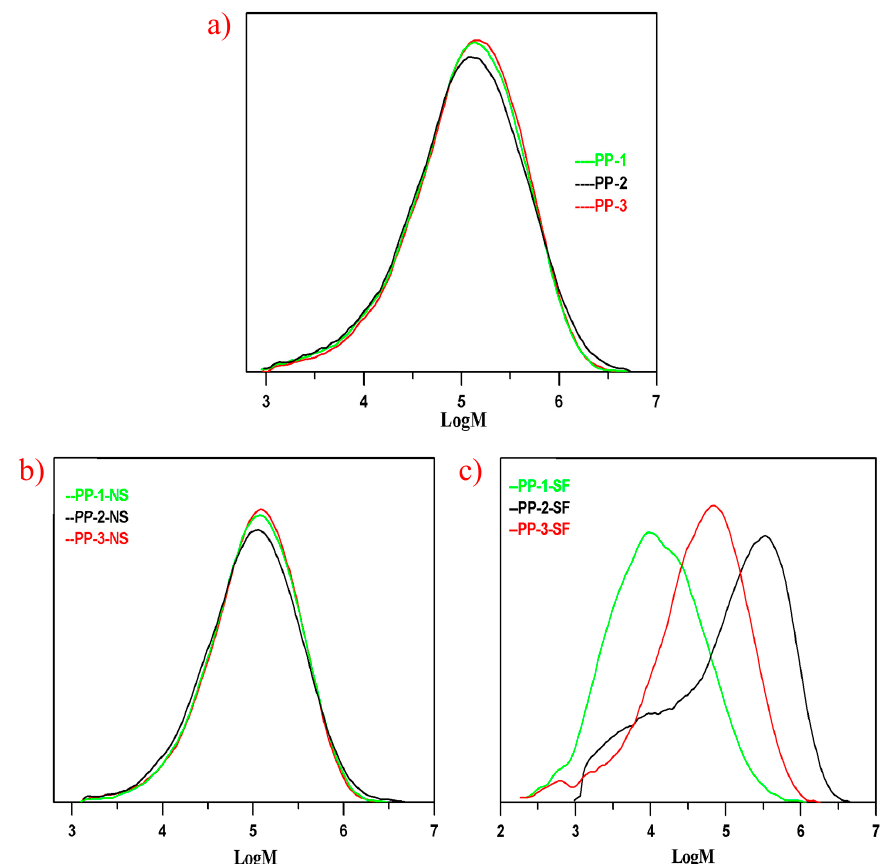
Figure 3. Molecular weight distribution curves of ( a ) PP samples, ( b ) non-soluble, and ( c ) soluble fractions from xylene at 25 °C.